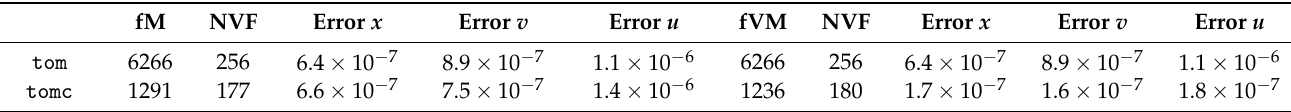
Table 2. Nonlinear Mass spring, T = 2 × 10 6 : final mesh (fM), total number of vectorized function evaluation (NVF) and mixed errors for x , v , u , initial mesh with 16 equidistant